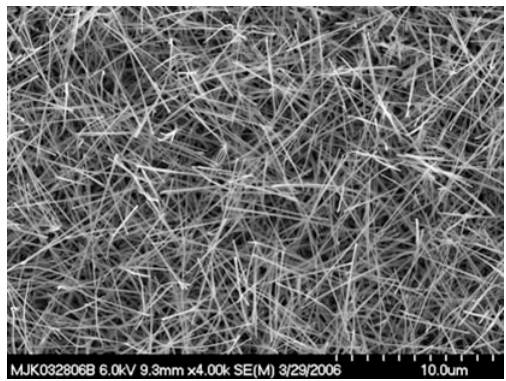
Figure 8. HTREM image of a TiO